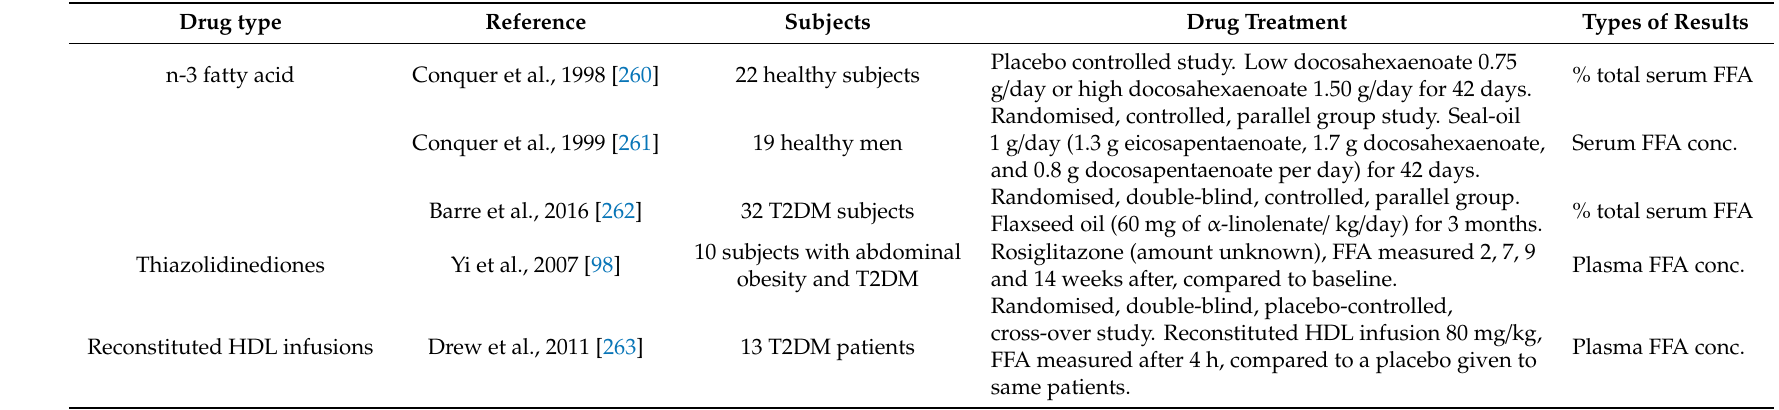
Table 4. List of studies having measured the concentrations of individual FFA species in the blood from subjects treated with lipid-lowering drugs and characteristics of the populations